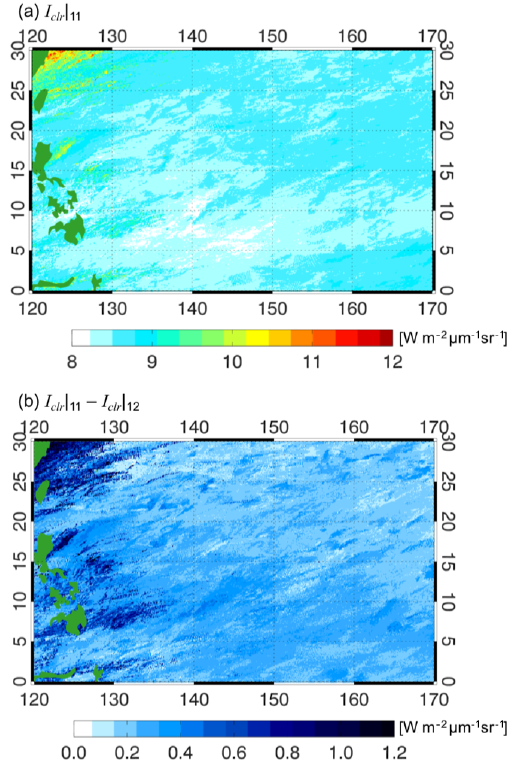
Figure 1. The estimated clear-sky radiance map at 0 . 1 ◦ × 0 . 1 ◦ res- olution for (a) 11µm ( I clr | 11 ) and (b) differences of 11µm from 12µm ( I clr | 11 − I clr | 12 ) in units of Wm − 2 µm − 1 sr − 1 . I clr | 11 and I clr | 12 are the maximum values among MODIS C6 radiances for August in 3 three years (2013–2015) in each 0 . 1 ◦ × 0 . 1 ◦ grid box. Green-shaded contours over the map show land, which is generally from the